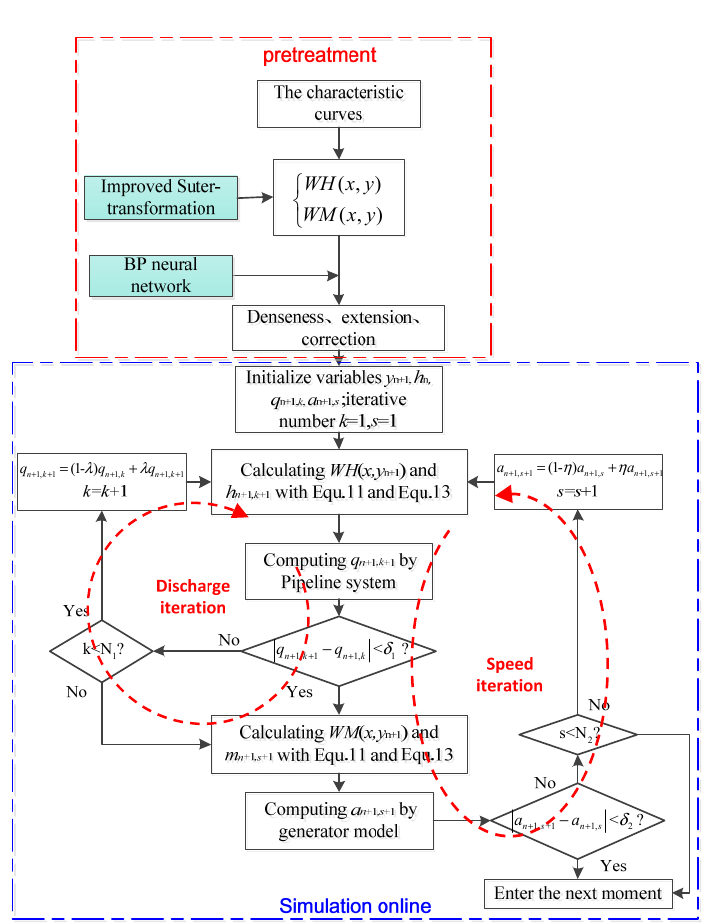
Figure 5. The flowchart of solving the pump-turbine model.